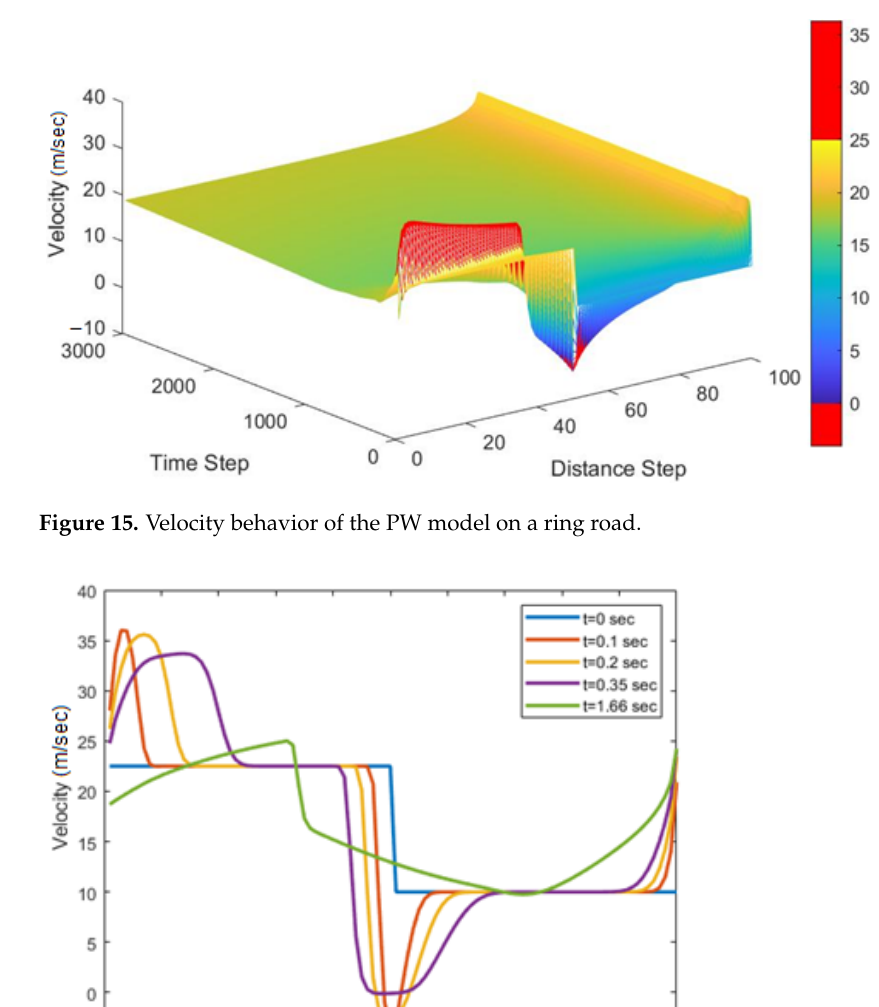
Figure 14. Density behavior of the PW model on a ring road.